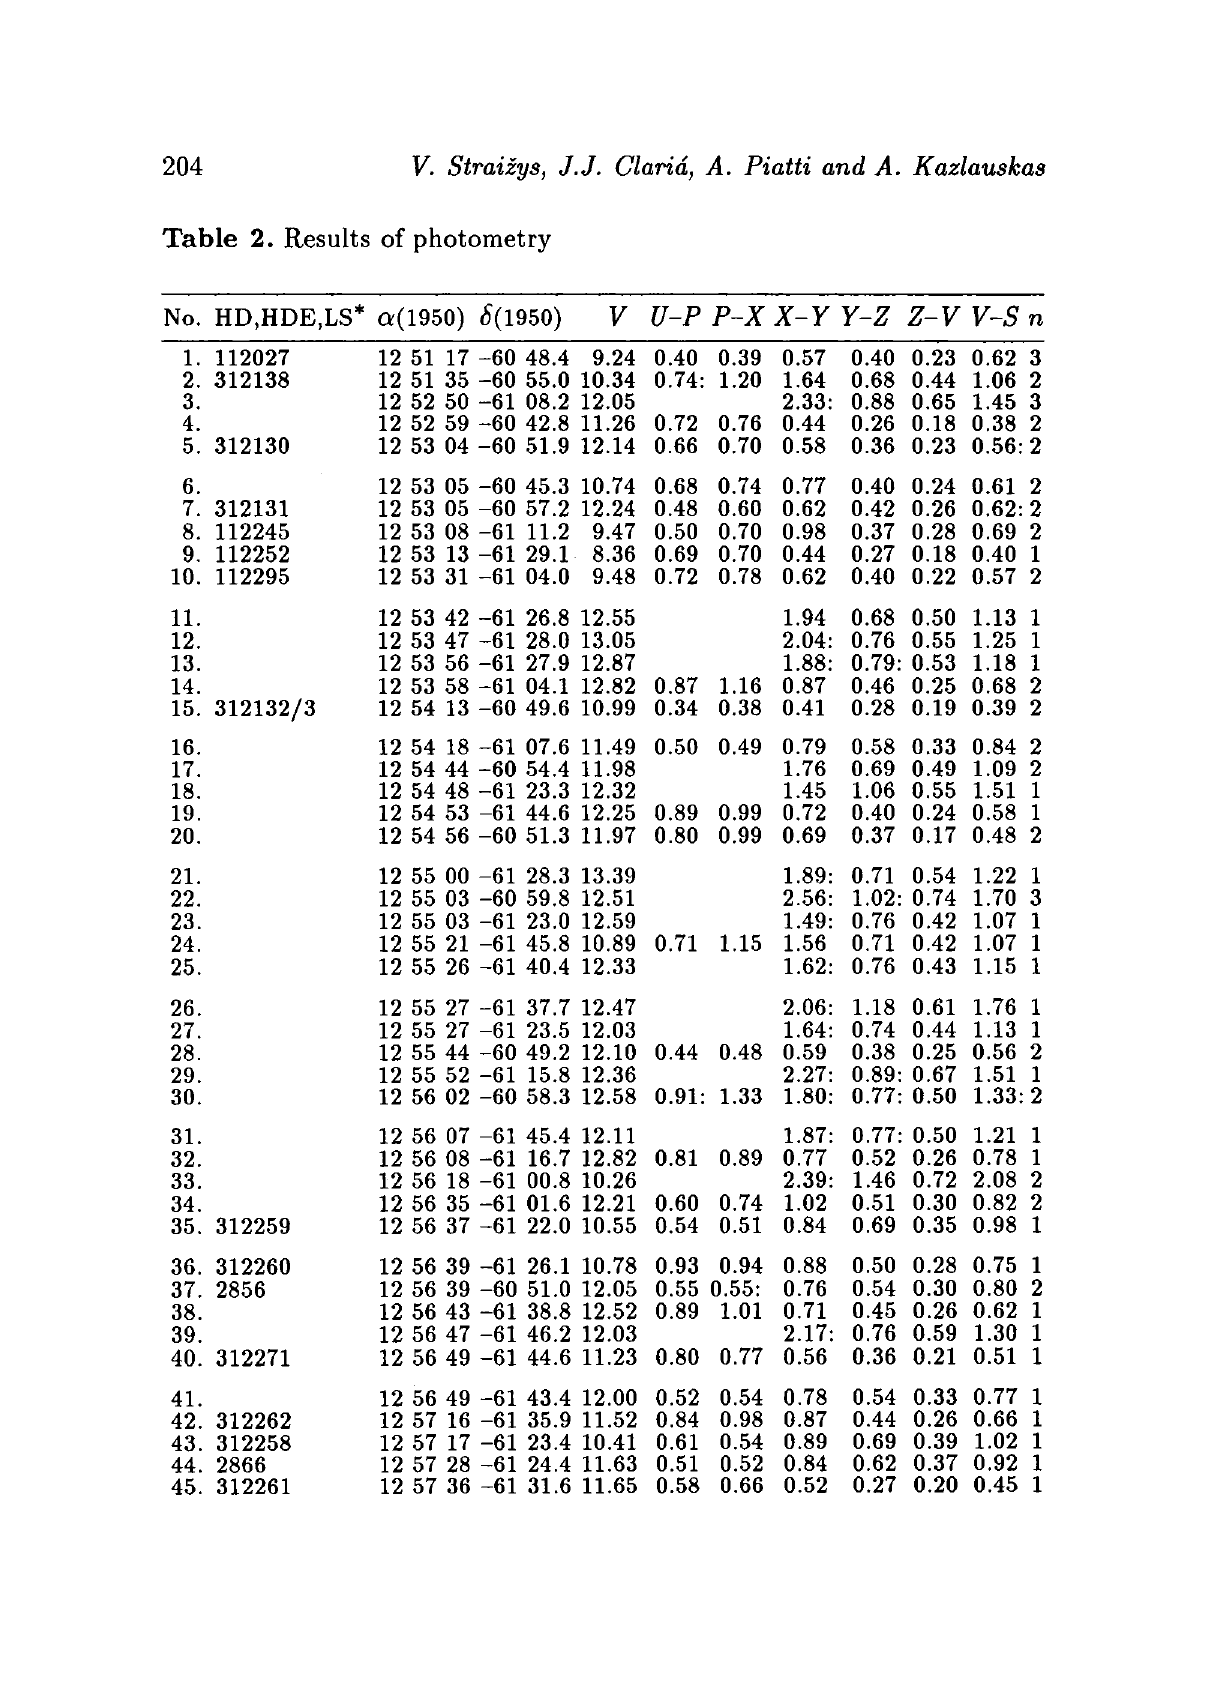
Table 2. Results of